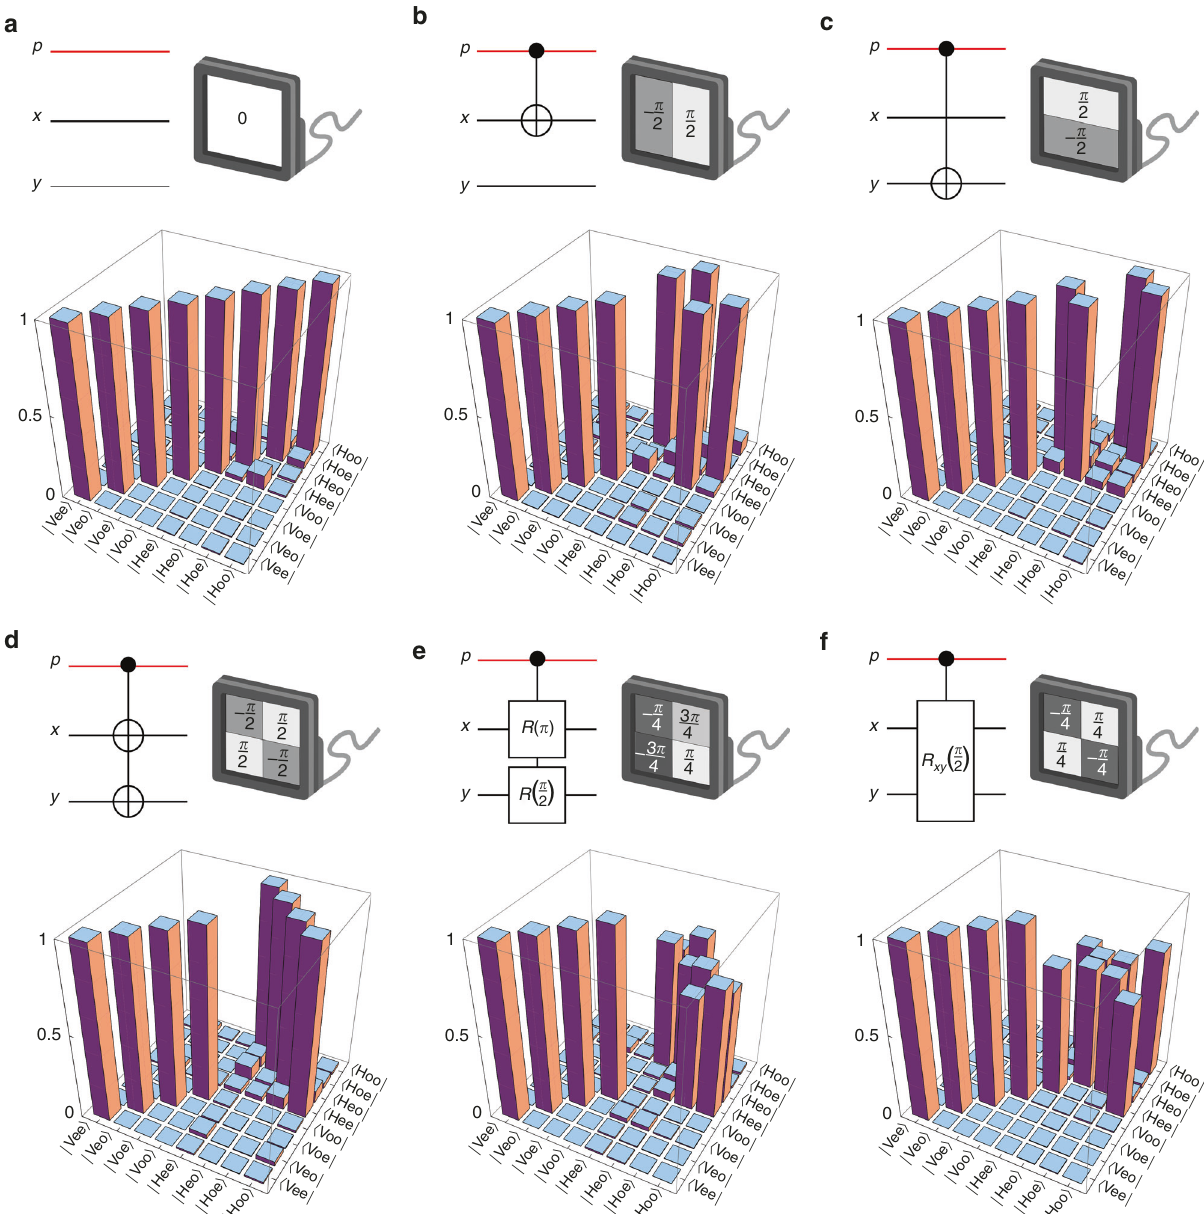
Fig. 6 Quantum-circuit representation and the measurement of operators for three-qubit gates. For the quantum gate in each panel, we present the quantum circuit, the 2D SLM phase required for implementing the gate, and the reconstructed transformation operator in the polarization-parity Hilbert space. a The identity gate I x (cid:3) I y ; b CNOT x (cid:3) I y ; c I x (cid:3) CNOT y ; d CNOT x (cid:3) CNOT y ; e a rotation R x ( π ) on the x -parity qubit and a rotation (cid:11) (cid:12) R y π on y -parity qubit, corresponding to the separable quantum gate CNOT x (cid:3) 2 y